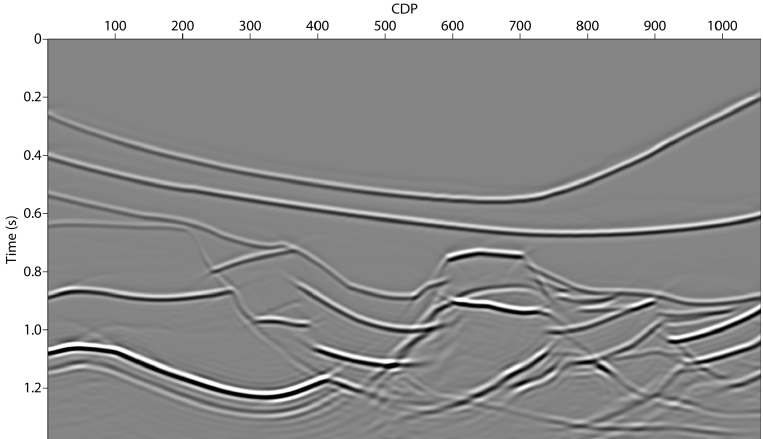
Figure 4. QPSTM image. After compensating the energy loss and correcting the phase distortion, the resolution of the image is improved. The fault planes can be clearly